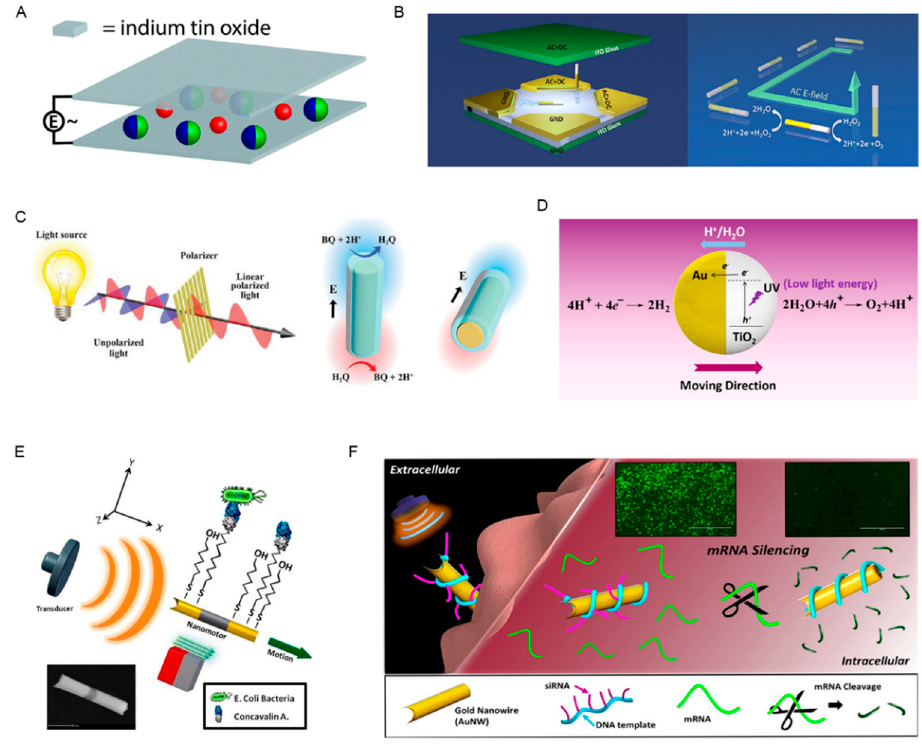
Figure 2. The working models of micro / nanorobots driven by exogenous power. ( A ) (reprinted from with [43] permission from Royal Society of Chemistry, 2018), ( B ) (reprinted from [23] with permission from American Chemical Society, 2018): Electric field propelled micro / nanorobot. ( C ) (reprinted from [46] with permission from John Wiley and Sons, 2019), ( D ) (reprinted from [50] with permission from American Chemical Society, 2016): Light energy propelled micro / nanorobot. ( E ) (reprinted from [55] with permission from American Chemical Society, 2013), ( F ) (reprinted from [57] with permission from American Chemical Society, 2016): Ultrasound energy propelled micro / nanorobot.